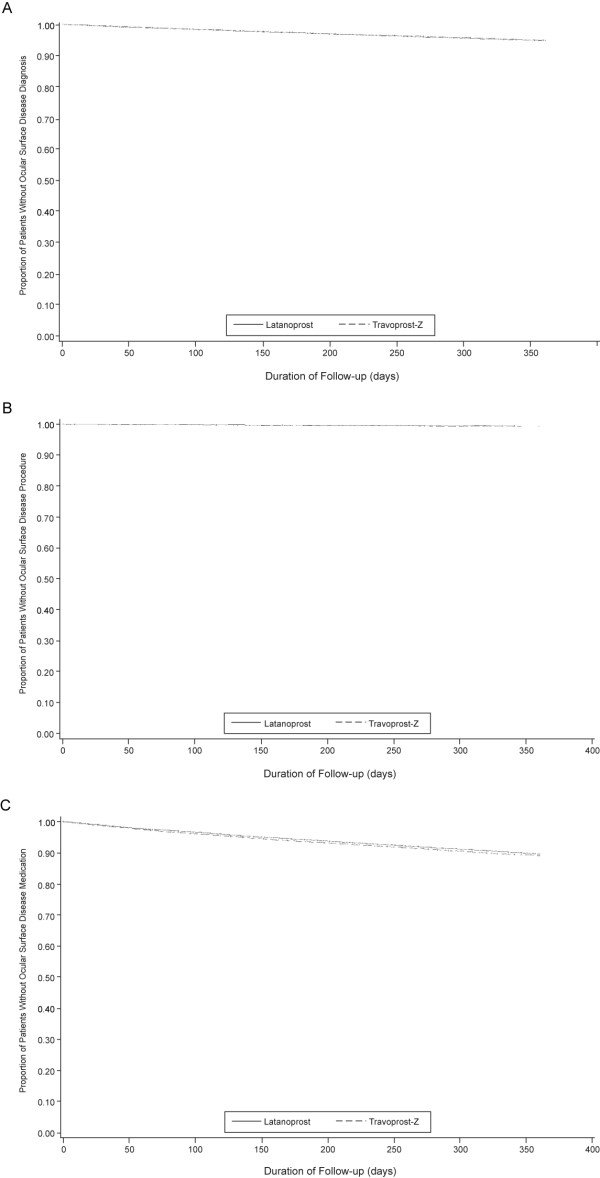
Days to ocular surface disease indicated by diagnosis (A), procedures (CPT code) (B), or prescription (C) by treatment group